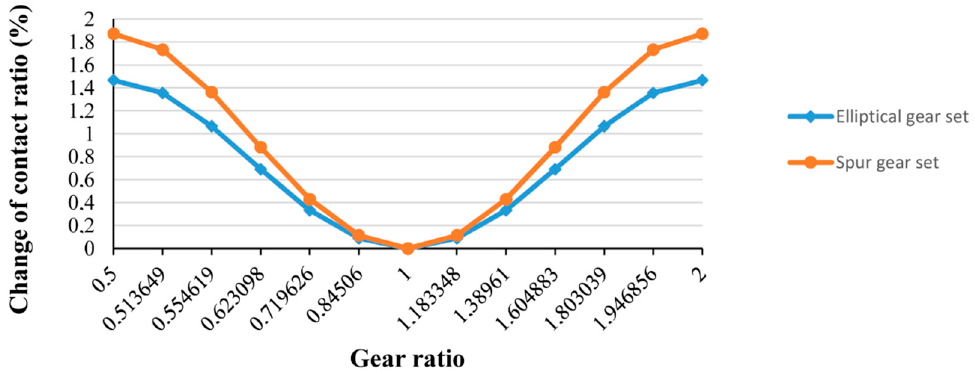
Figure 25. Comparison of the change of the contact ratio parameter.